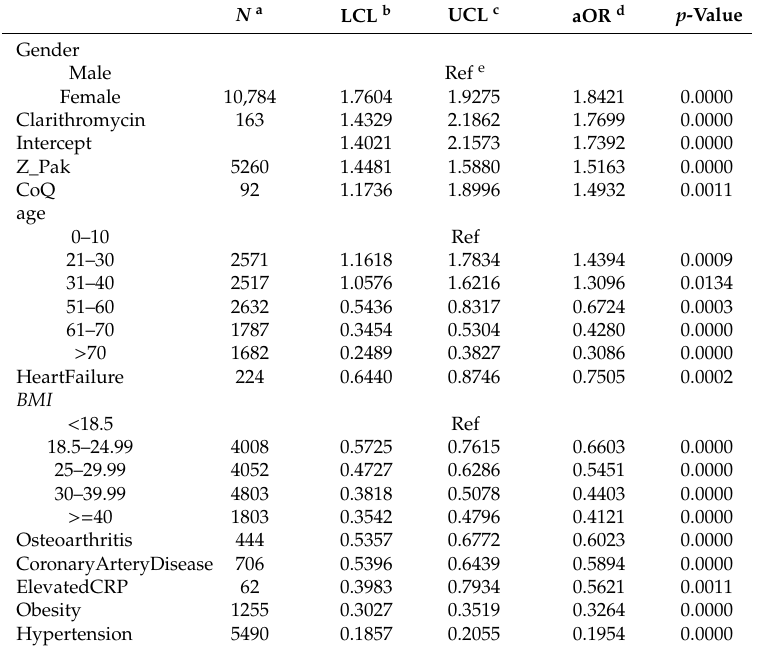
Table 4. Association of dietary supplements, antibiotics, and comorbidities for anxiety.